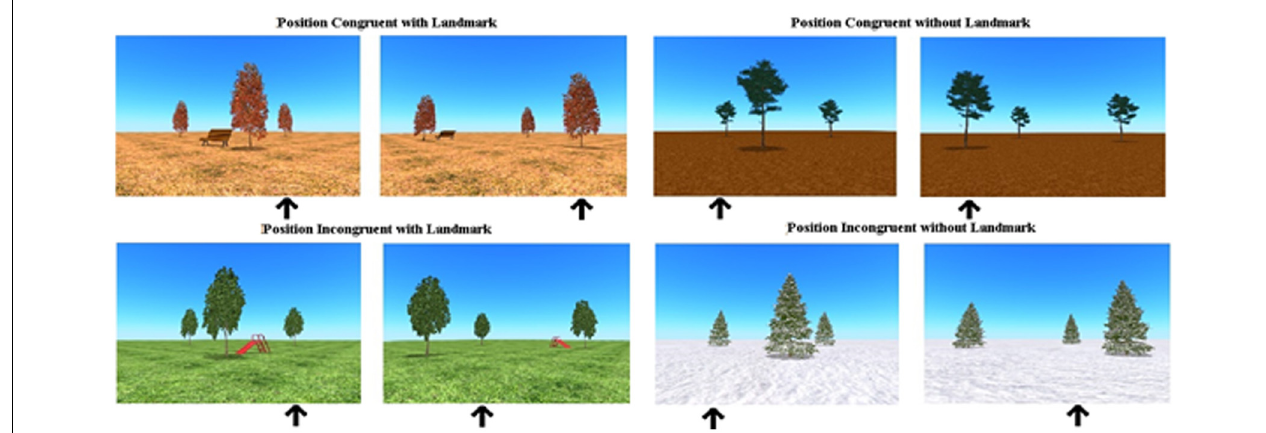
FIGURE 2 | Overview of position congruent (ego- as well as allocentric strategies are successful) and position incongruent trials (only allocentric strategy is successful), with and without a landmark in the virtual spatial memory task.